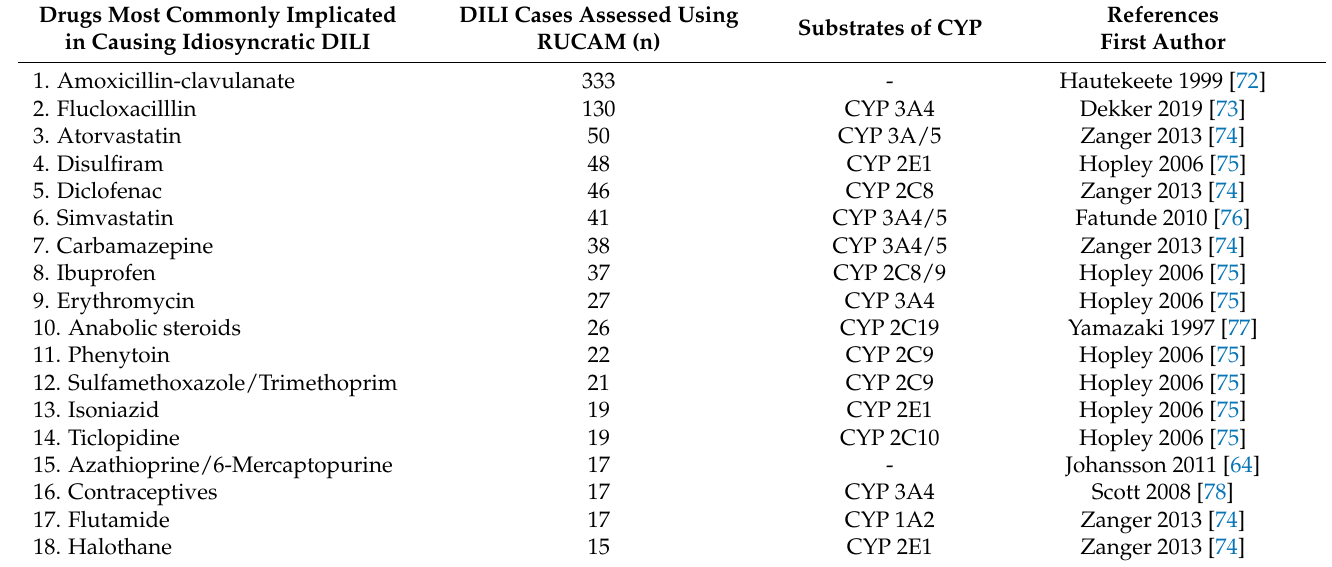
Table 3. CYP involvement in DILI by various drugs as assessed in RUCAM based